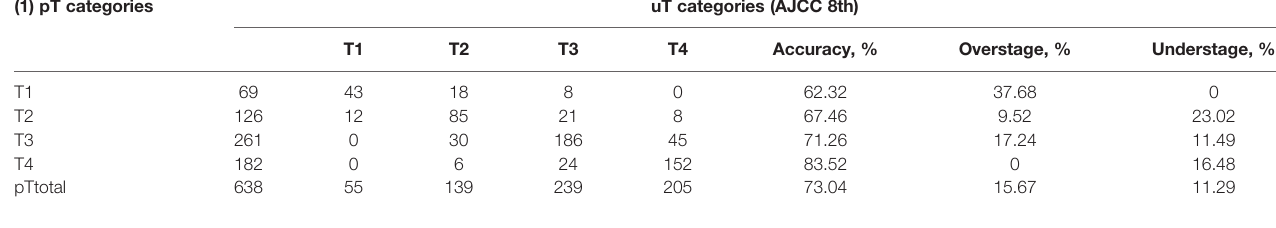
TABLE 3 | Results of endosonography (uT) categories and pathologic T (pT) categories for (1) all patients, (2) rectal cancer patients, and (3) colon cancer patients. (1) pT